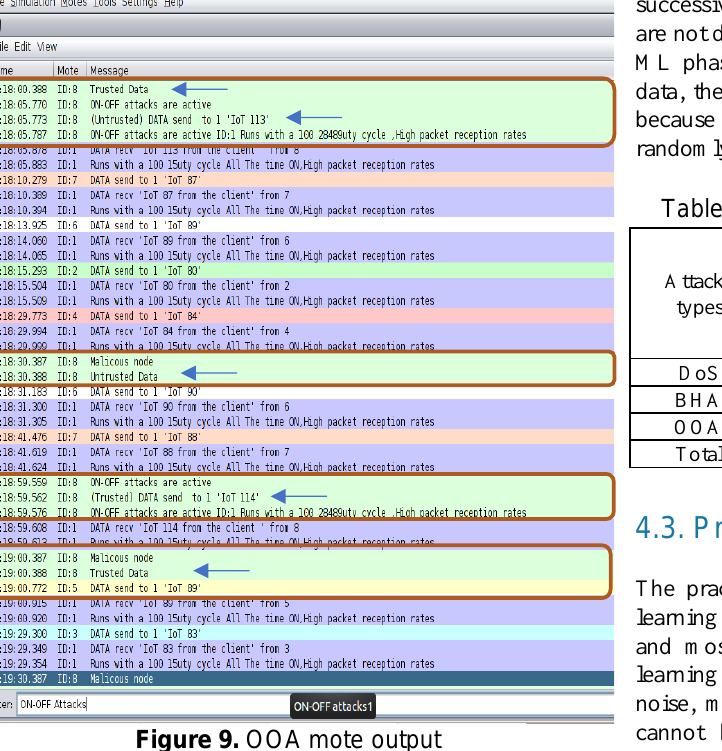
Figure 9. OOA mote output